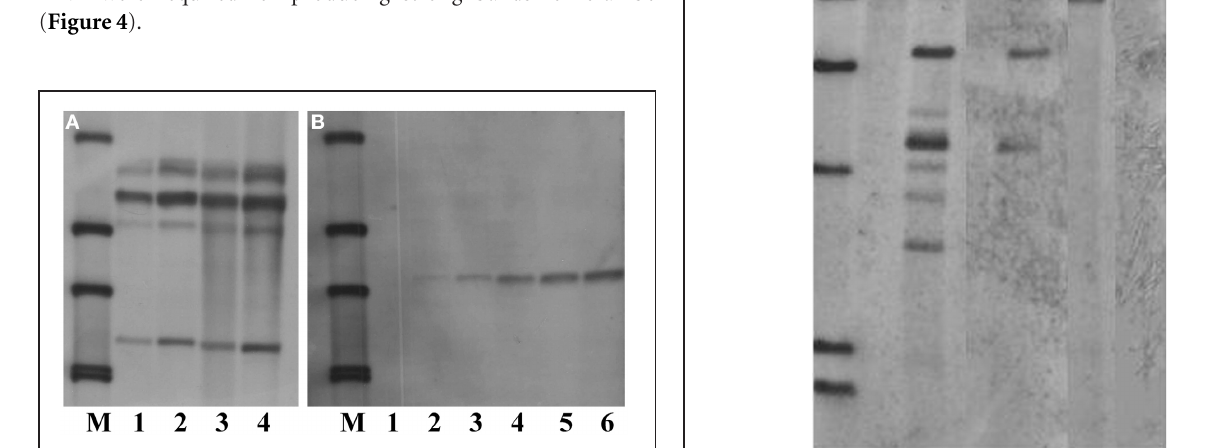
(A,B) From lane 1 to 13: Bgl II, Kpn I, Sac I, Sal I, Sma I, Stu I, Hin dIII, Xho I, Xba I, Pst I, Eco RV, Dra I, and Bam HI. M, DIG labeled molecular markers. DNA, 80 µ g. Enzyme, 20 µ